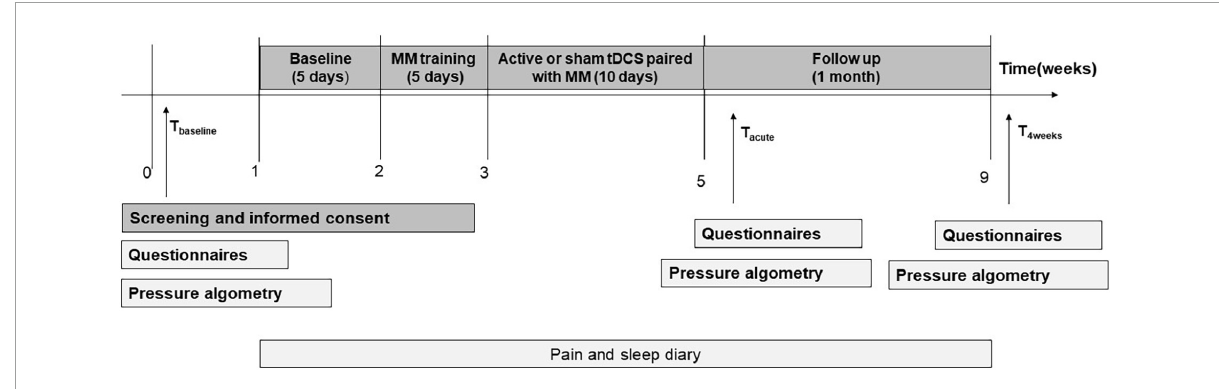
FIGURE2 Study design for the active + MM and sham + MM treatment